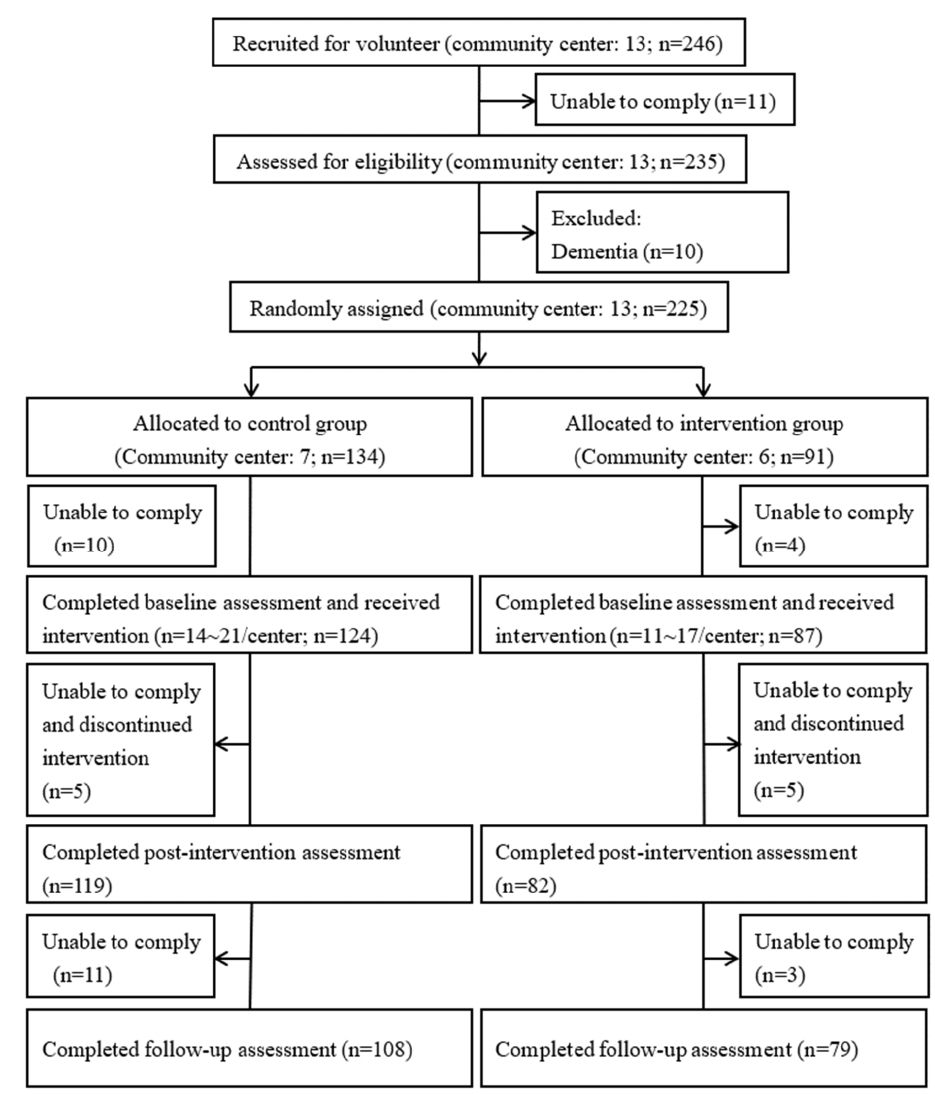
Figure 1. Flow of